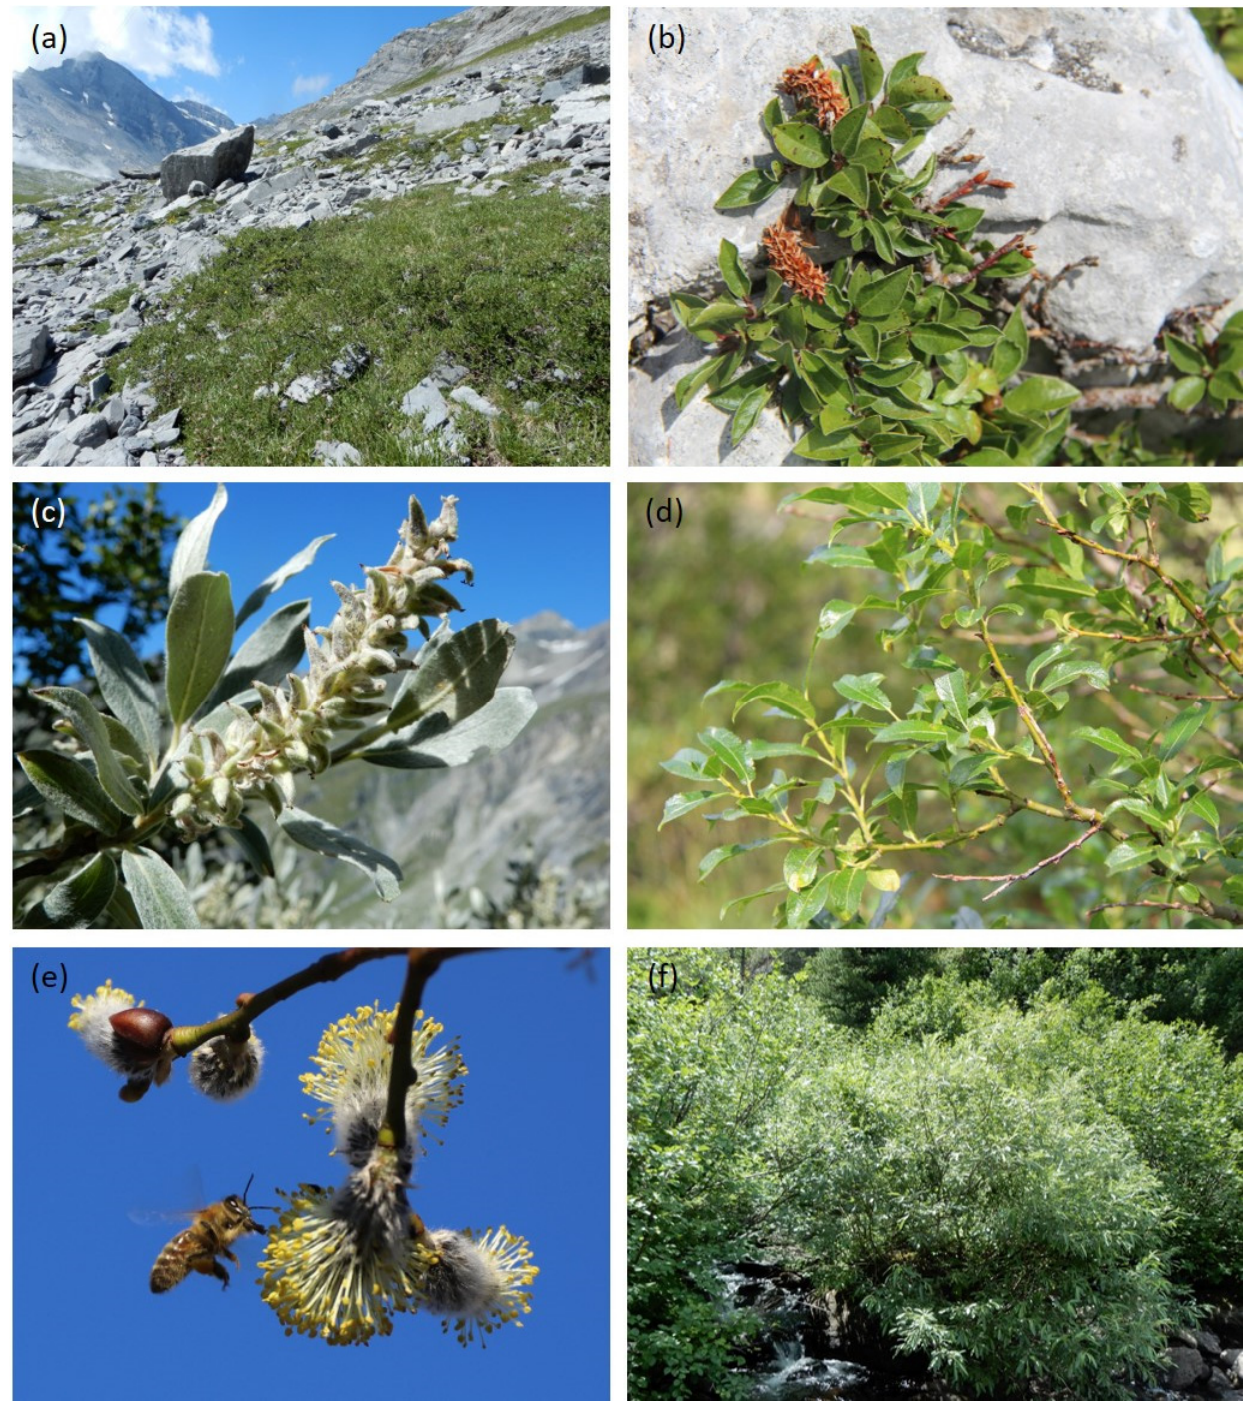
Figure 1. Selected Salix species that occur in the Alps. ( a ) S. breviserrata creeping dwarf shrub, ( b ) S. alpina with female catkins, ( c ) S. glaucosericea with female catkin, ( d ) S. mielichhoferi leaves, ( e ) S. aurita male catkins, ( f ) S. laggeri shrub. Photographs taken by N.W. and E.H.